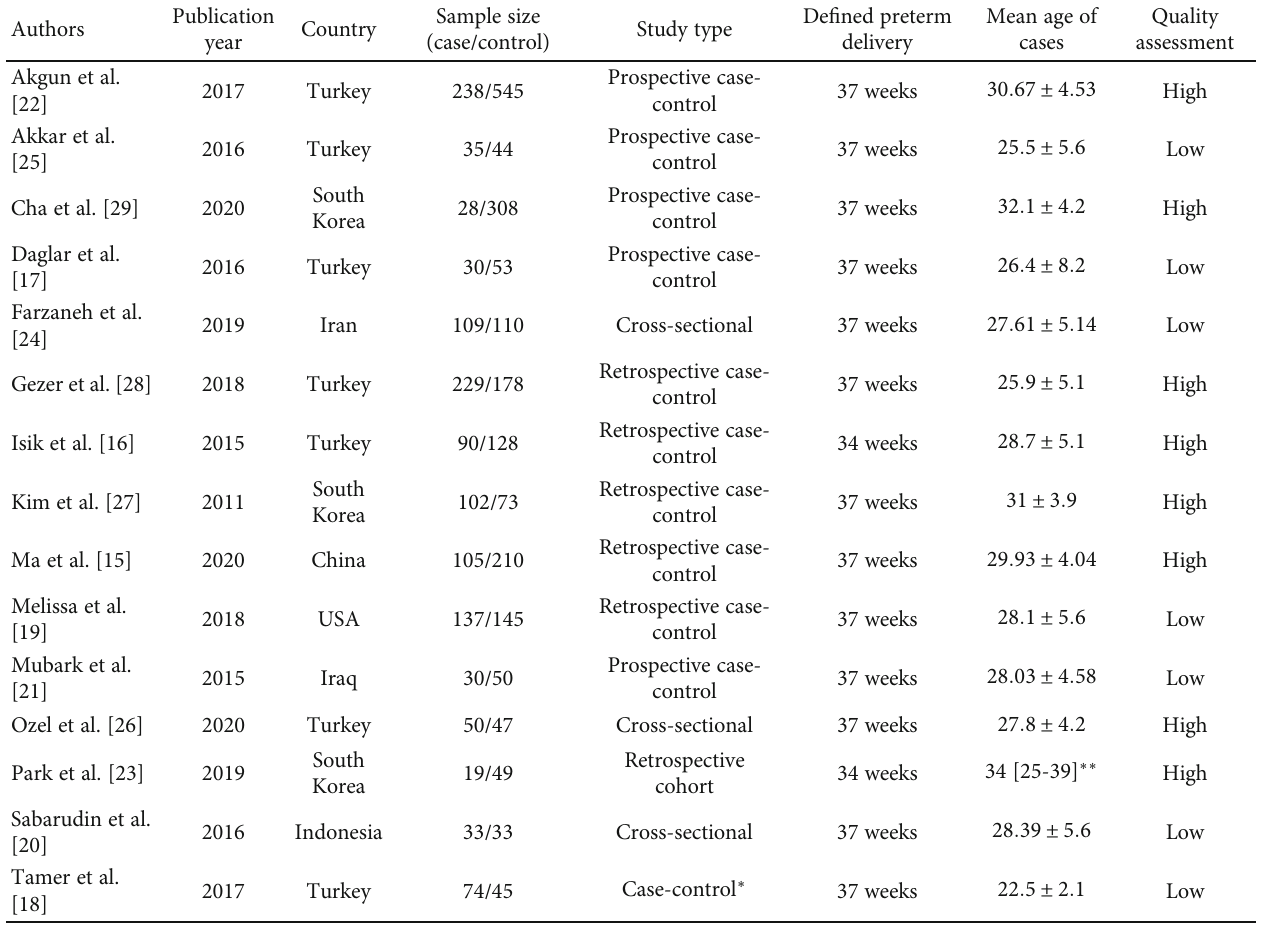
Table 1: Characteristics of included studies assessing the association between NLR and preterm